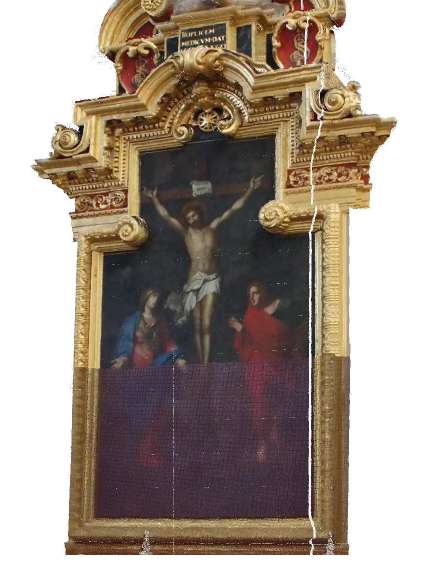
Figure 13: Painting in the chapel of the Saint-Sebastian before (bottom) and after (top) its colorization.